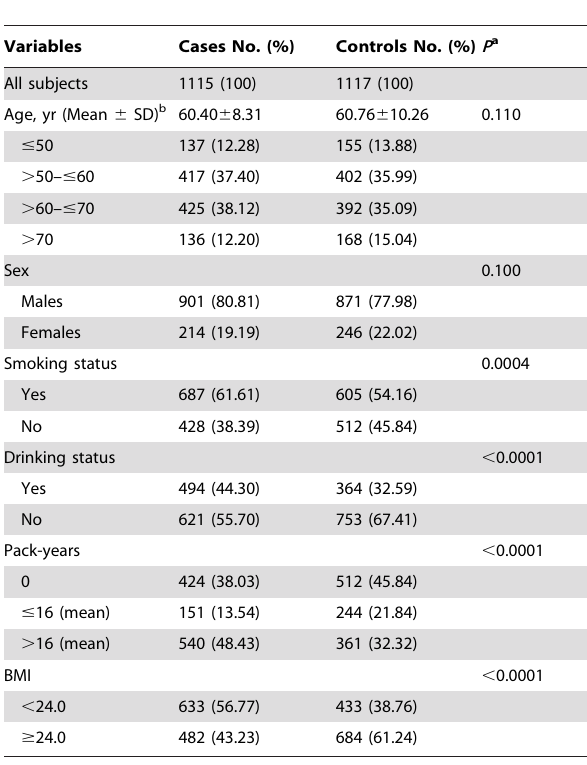
Table 1. Distributions of selected variables in ESCC cases and cancer-free